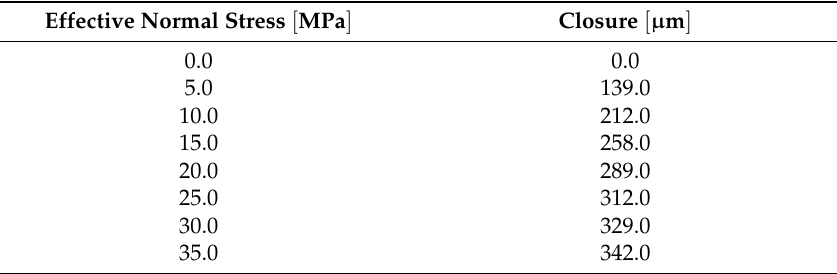
Table 1. Effective normal stresses ( σ (cid:48) ) and closures used in this study [20].